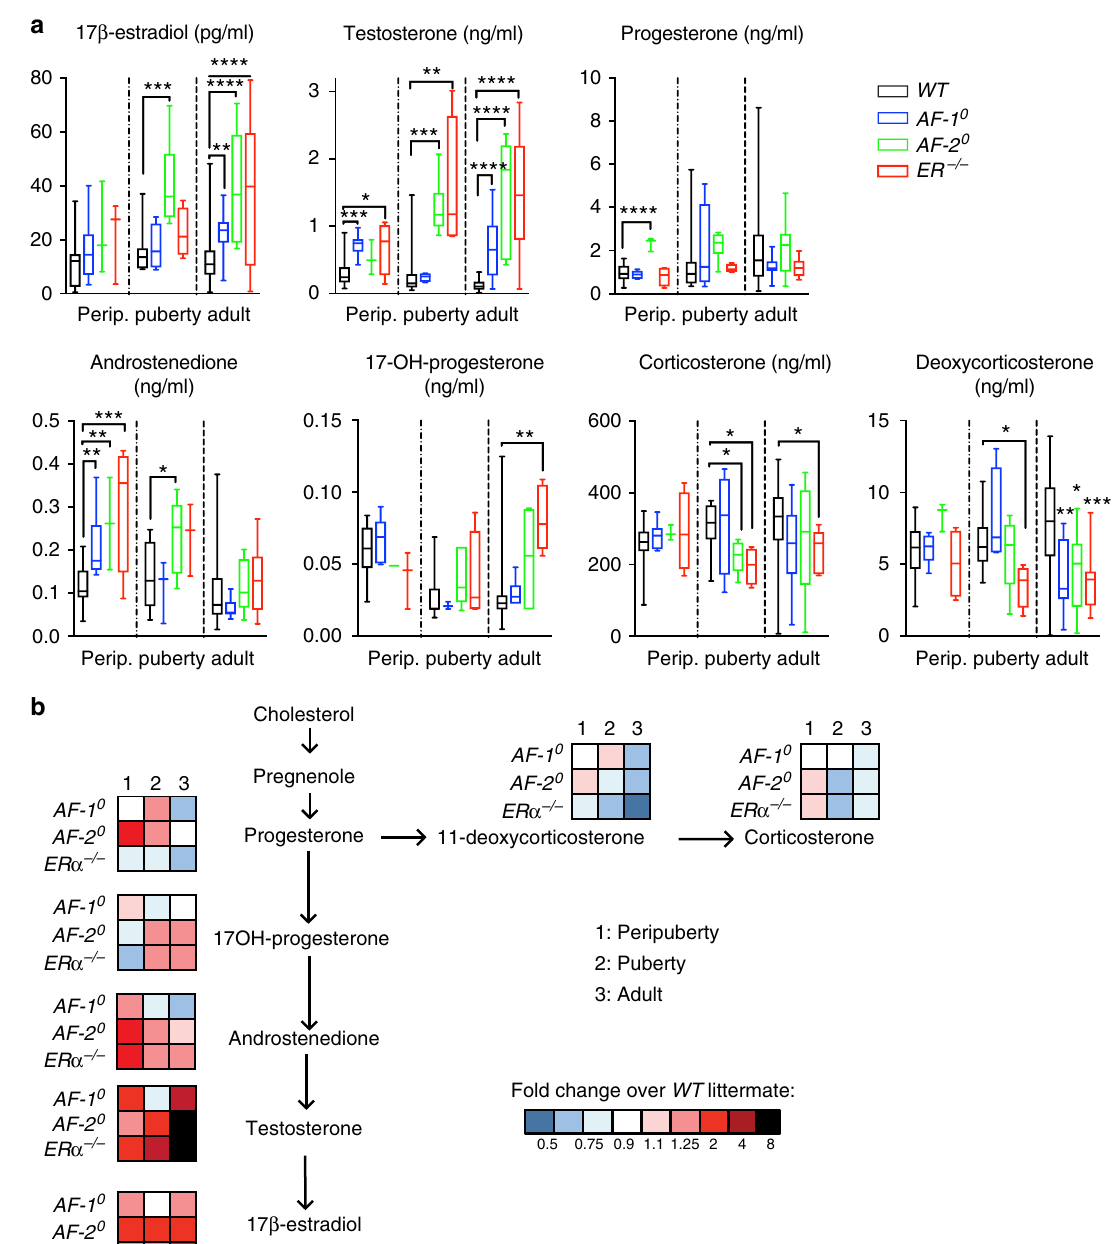
Fig. 2 Steroid hormone levels in ER α AF-1 0 , ER α AF-2 0 and ER α − / − mice. a Box plots showing plasma levels of 17- β -estradiol, testosterone, progesterone, androstenedione, 17-OH-progesterone, corticosterone and deoxycorticosterone determined by LC/MS measured in peripubertal (3-week old), pubertal (4- to 7-week old) and adult (>8-week old) WT , AF-1 0 , AF-2 0 and ER α − / − females ( n = 3 – 25). Horizontal lines outside the boxes depict minimum and maximum values, upper and lower borders of the boxes represent lower and upper quartiles, and the line inside the box identi fi es the median. Unpaired, Mann – Whitney test. b Mean serum levels of the different steroids (shown in a ) were plotted relative to average levels in WT littermates in the context of major biosynthetic pathways. Colour code represents fold changes over levels in the WT We hypothesised that the residual PgR expression in AF-1 0 contralateral WT.GFP + grafts showed increased side branching epithelium may account for the partial outgrowth in this mutant (Supplementary Figure 2b) con fi rming successful delivery of observed in the older females and during pregnancy. To test progesterone, the AF-1 0 .GFP + epithelial grafts remained rudi- mentary (Supplementary Figure 2c) indicating that activation of PgR signalling is not suf fi cient to stimulate ductal elongation in AF-1 0 epithelial grafts. These observations support a model where the function of ER + sensor cells relies on both AF-1 and AF-2 for the transcription of Areg and Wnt4 and potentially other factors and/or cell-intrinsic functions required for ductal elongation.